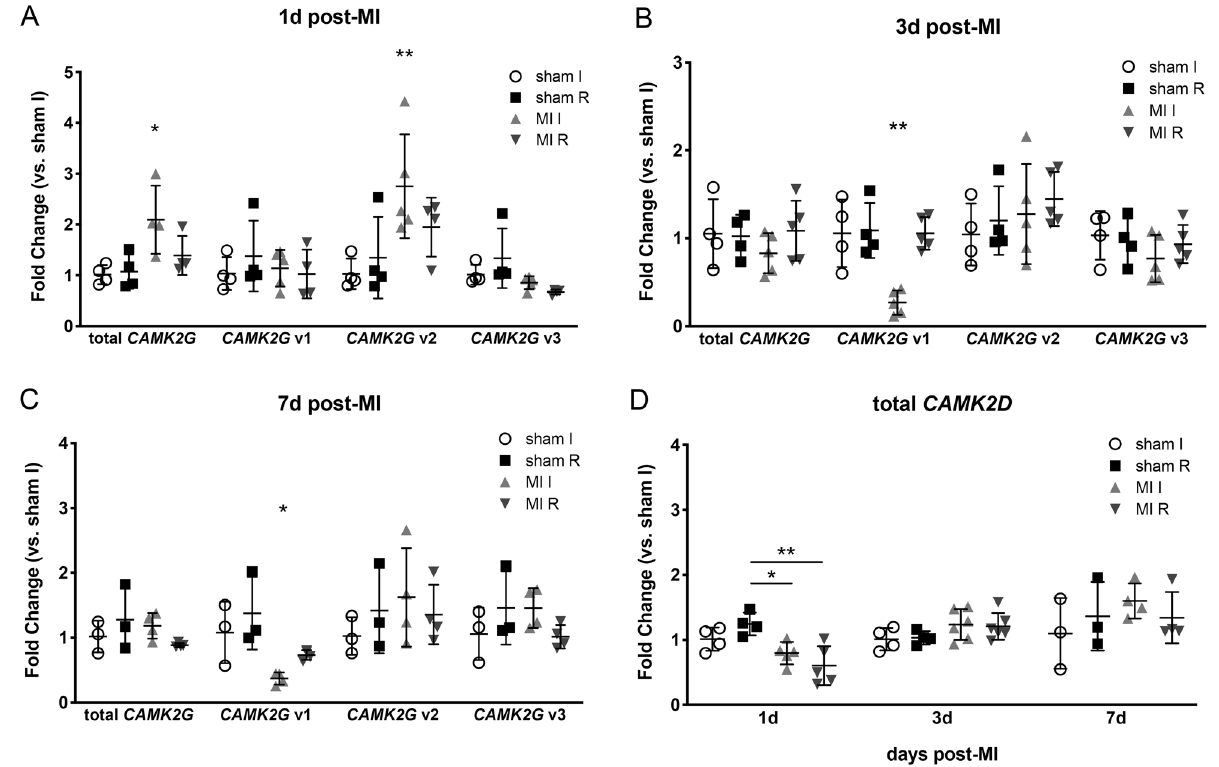
Figure 3. Real-time PCR reveals decrease in CAMK2G v1 expression post-MI. ( A – C ) rt-PCR data for total CAMK2G and splice variant expression in WT hearts at 1 day ( A ), 3 days ( B ) and 7 days post-MI ( C ). Using one-way ANOVA with Tukey’s multiple comparisons, overall p values for total CAMK2G , CAMK2G v1, CAMK2G v2 and CAMK2G v3, respectively, were p = 0.015, p = 0.47, p = 0.021 and p = 0.05 for panel A, p = 0.57, p = 0.0005, p = 0.56 and p = 0.48 for panel B and p = 0.28, p = 0.014, p = 0.63 and p = 0.26 for panel C. ( D ) Total CAMK2D expression over the course of 7 days post-MI as assessed by rt-PCR. Using one-way ANOVA with Tukey’s multiple comparisons, overall p -values were p = 0.0037, p = 0.20 and p = 0.53 for 1 day, 3 days and 7 days post-MI, respectively. * p < 0.05, ** p < 0.01 for between group comparisons. I = ischemic tissue (infarct +